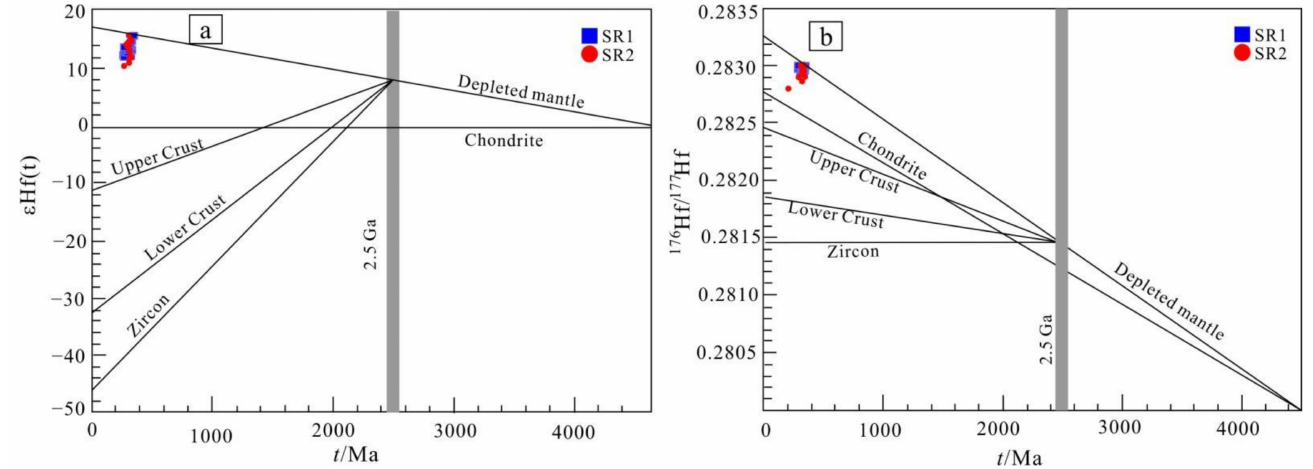
Figure 11. Zircon Hf isotopic compositions ( a ) and temporal variations ( b ) of the medium-fine- grained granites and granite porphyry in the Sayashk Sn